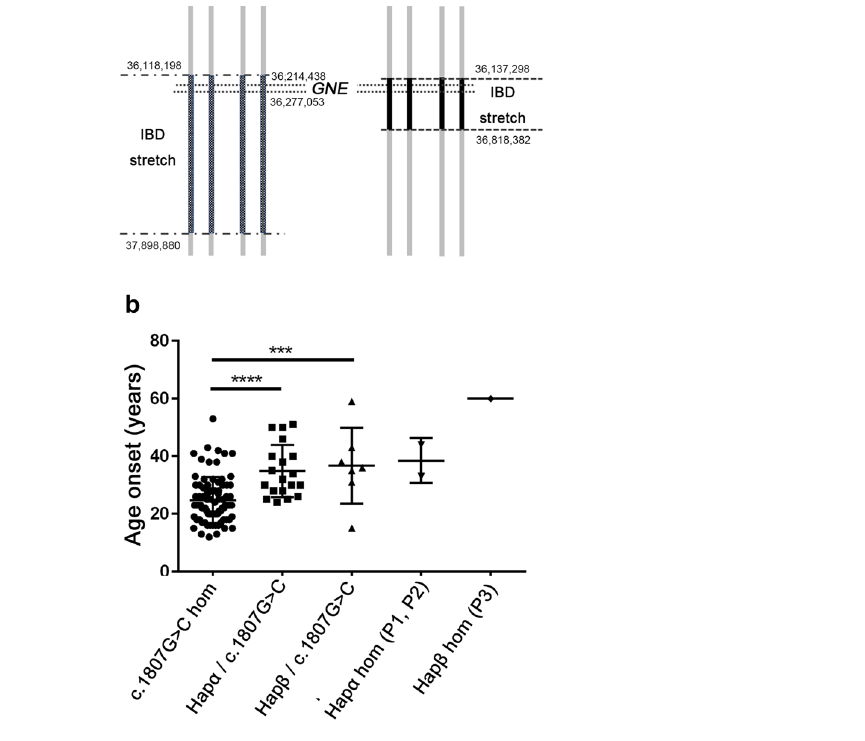
Figure 1. Two distinct haplotypes of patients carrying c.620A>T. ( a ) Two distinct haplotypes carrying the c.620A>T allele. IBD analysis of c.620A>T homozygotes. An IBD stretch spanning 1780 kb (Chr9: 36,118,198– 37,898,880), including the whole of GNE , was identified in P1 and P2. A different IBD stretch, spanning 680 kb (Chr9: 36,137,298–36,818,382), and also including the whole of GNE , was identified in P3 and H1. ( b ) Age at onset of patients homozygous for c.1807G>C and c.620A>T. Haplotype α was shared by P1 and P2. Haplotype β was shared by P3 and H1. Age at onset of c.620A>T/c.1807G>C compound heterozygous patients (hapα: n = 19, hapβ: n = 7) was later than in those homozygous for c.1807G>C (n = 84). There was no significant difference between patients carrying Haplotype α and Haplotype β. The ages at onset of P1, P2, and P3 were 37, 34, and